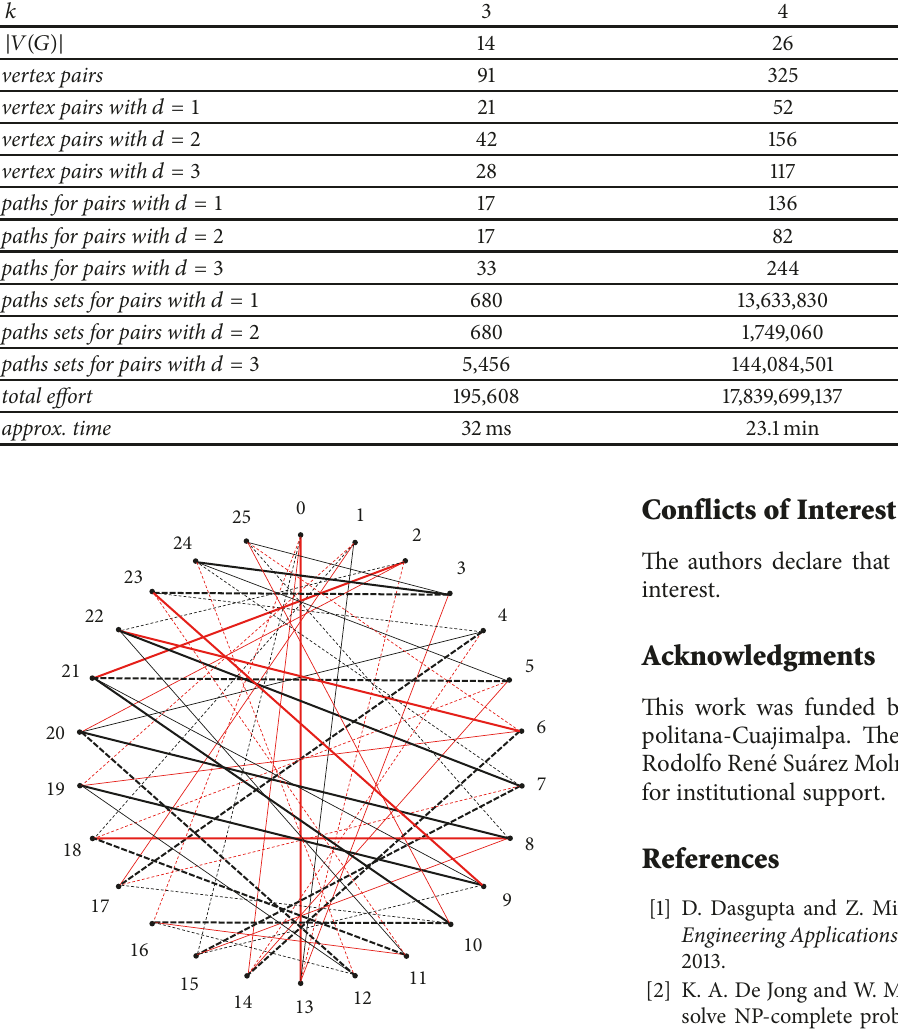
Figure 2: Sample rainbow coloring with 𝑘 = 4 and 𝑛𝑢𝑚𝐶𝑜𝑙𝑜𝑟𝑠 = 7